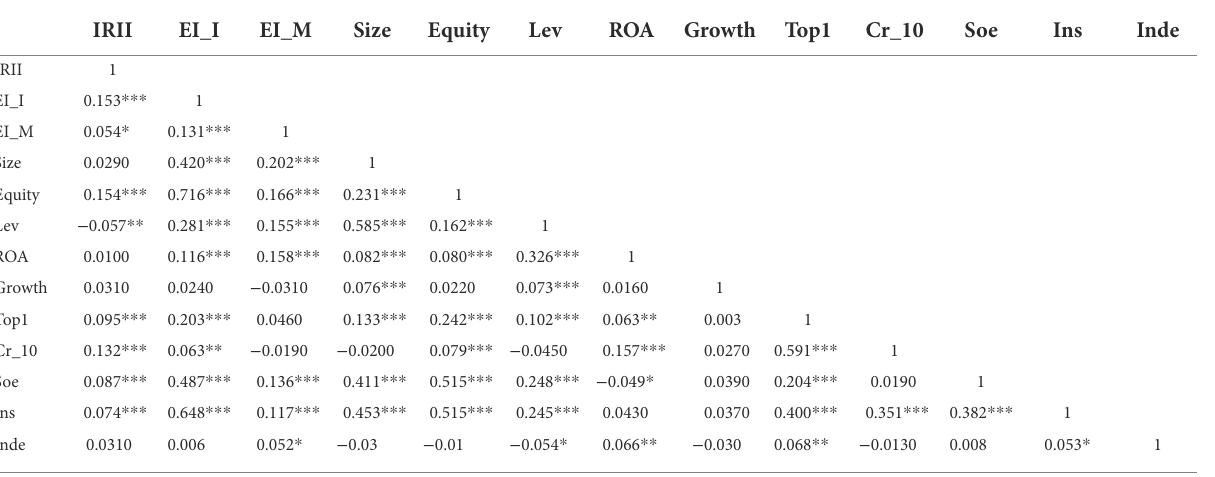
TABLE 4 Correlation matrix (EI_I and